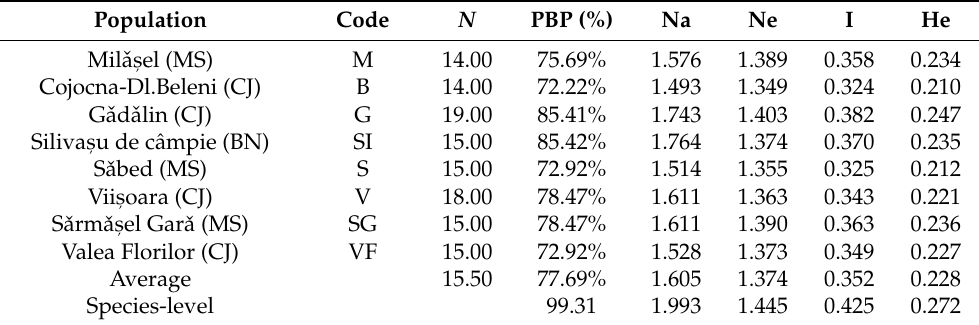
Table 3. Genetic diversity indices of Astragalus exscapus subsp. transsilvanicus populations based on SRAP molecular marker analysis.